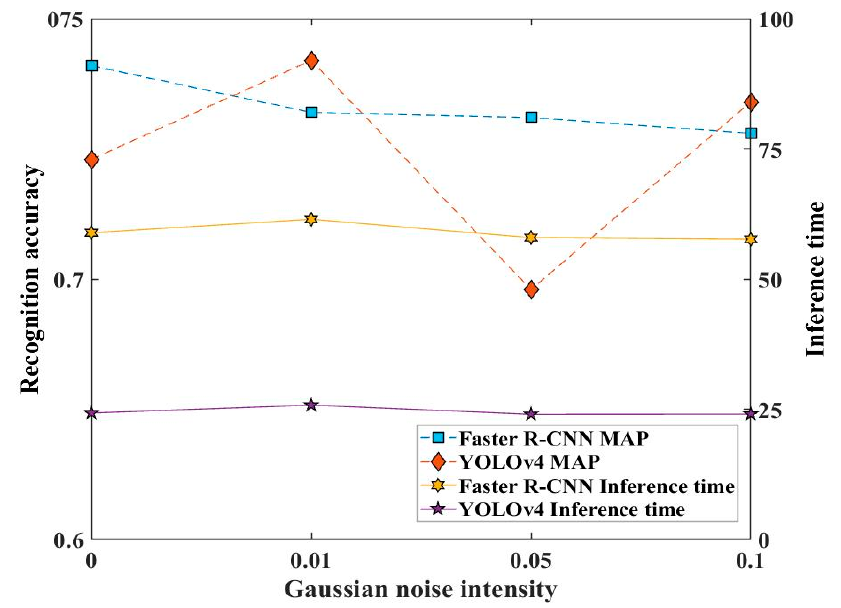
Figure 12. Effect of Gaussian noise of developing datasets on the recognition accuracy and inference time of the two approach models.